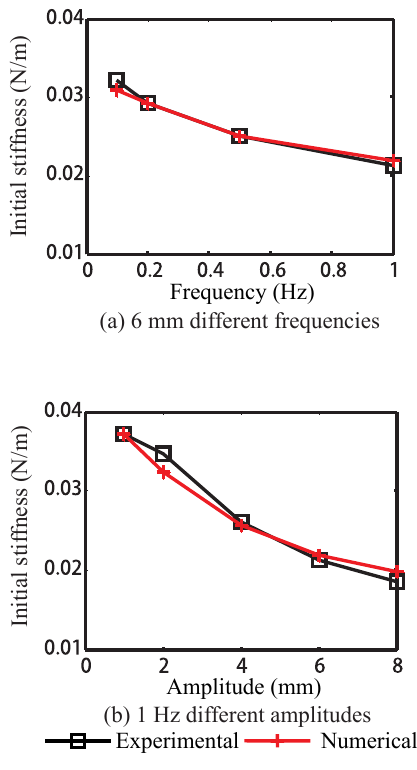
Fig. 13. Comparison of damping ratio between experimental and nu- merical